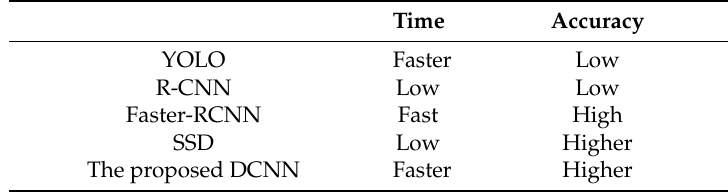
A comparison of different CNNs is shown in Table 3. Table 3. The comparison of different CNN. Table 3. The comparison of different